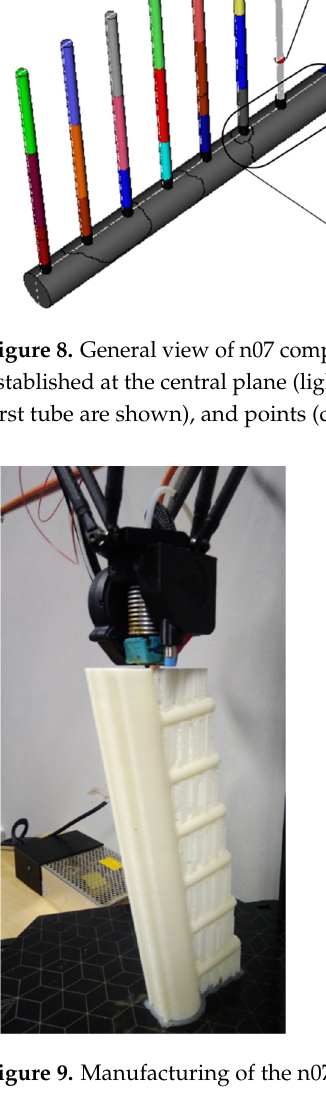
Figure 9. Manufacturing of the n07 distributor.